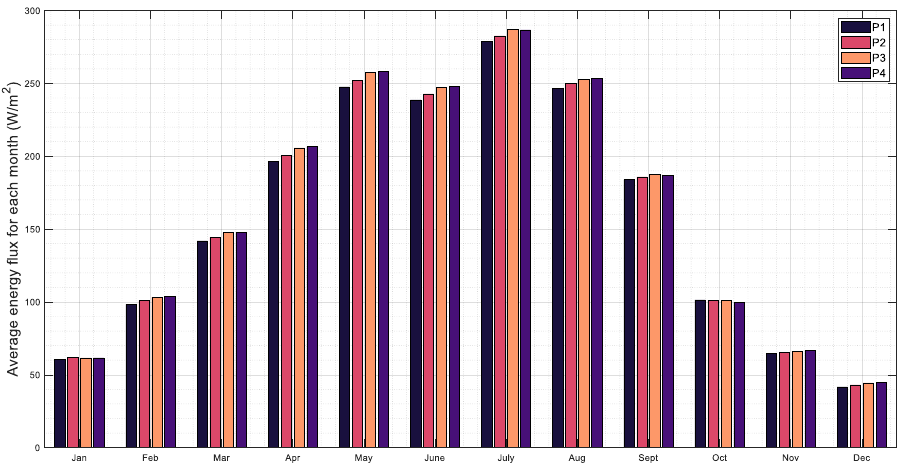
Figure 3. Monthly average GHI of solar irradiance ( W/m 2 ).